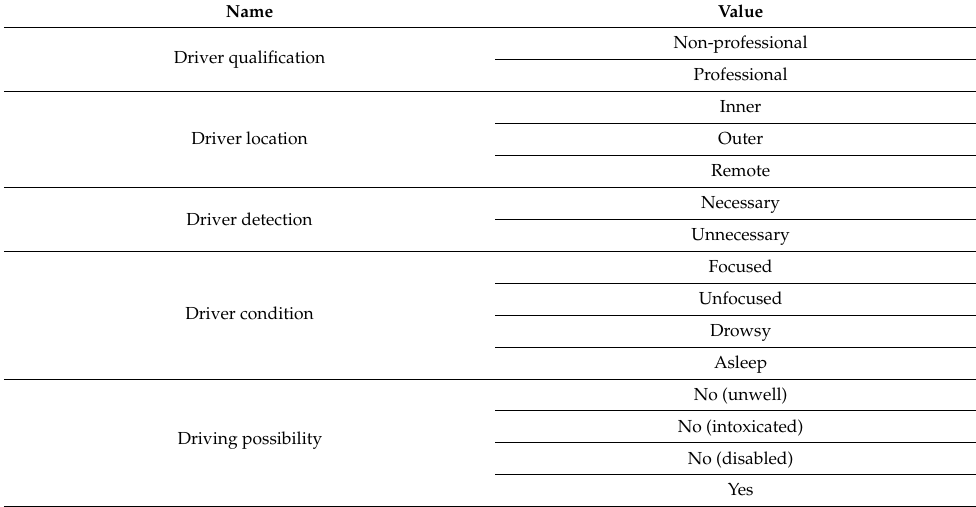
Table 3. Scenario classification—driver.